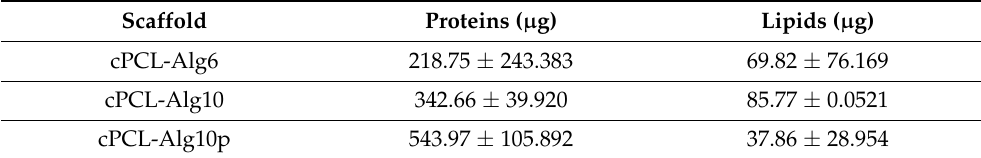
Figure 7. In vitro protein ( A ) and lipid ( B ) release profiles from PCL-Alg6, PCL-Alg10, and PCL-Alg10p scaffolds immersed in pH 7.2 PBS at room temperature. On the right, for each graph, an enlargement of the first 8 h of release is reported ( C , D for PCL-Alg6 and PCL-Alg10, respectively). Multifactor ANOVA, mean values ± least significant difference (LSD), n = 3. Table 5. Protein and lipid loading for cPCL-Alg6, cPCL-Alg10, and cPCL-Alg10p scaffolds. Mean values ± standard deviation ( n =